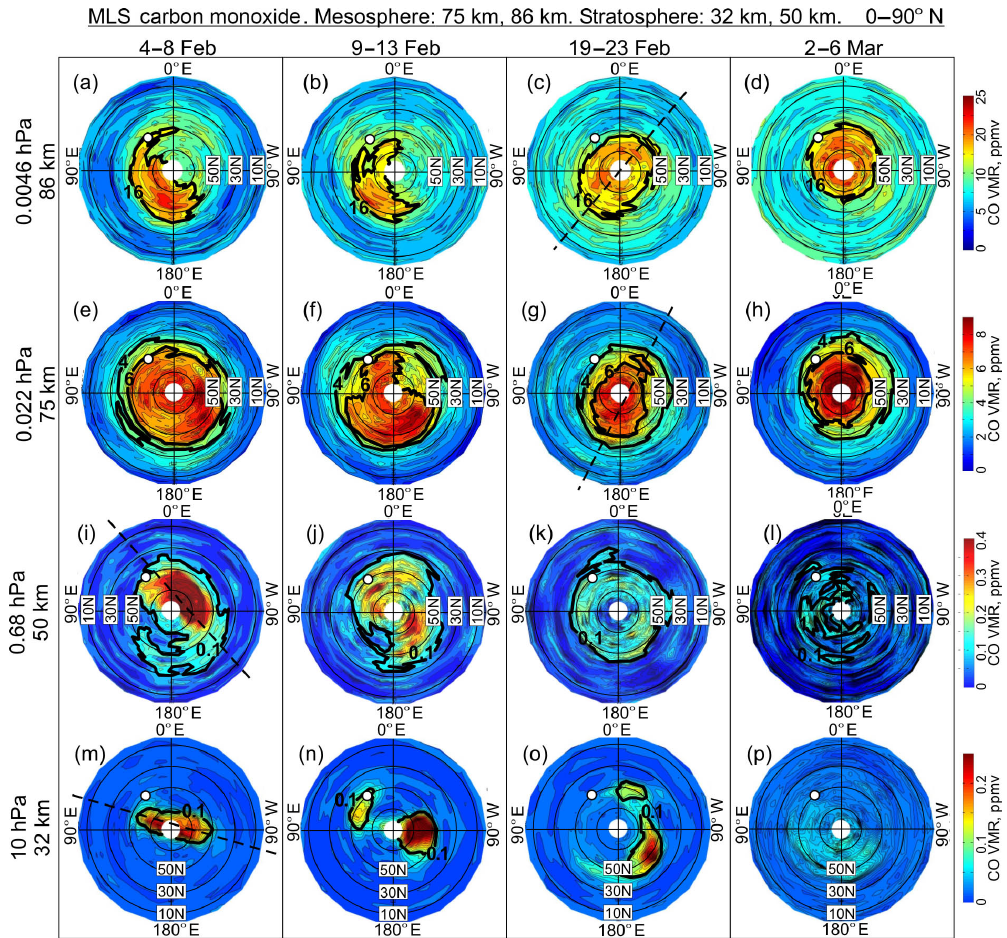
Figure 4. The 5d mean CO field over the NH (0–90 ◦ N) from the MLS measurements at the two mesospheric (75 and 86km) and stratospheric (32 and 50km) levels before (4–8 February), during (9–13 and 19–23 February), and after (2–6 March) the SSW 2018. White circle shows the location of the MWR site, Kharkiv, relative to the high/low CO amounts marked off by black contours. Dashed lines indicate clockwise rotation of the elongated polar vortex with altitude as manifestation of upward propagation of planetary waves with their westward tilt with